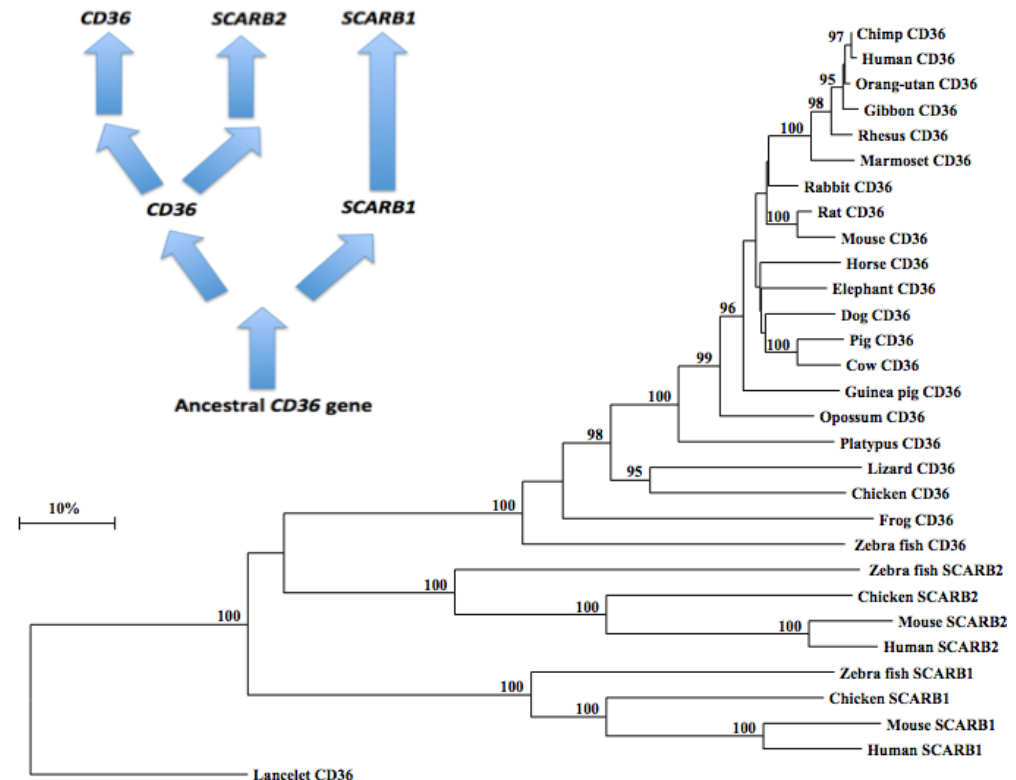
Figure 5. Phylogenetic Tree of Vertebrate CD36 Amino Acid Sequences with Human, Mouse, Chicken and Zebrafish SCARB1 and SCARB2 Sequences. The tree is labeled with the CD36 -like gene name and the name of the animal and is ‘rooted’ with the lancelet CD36 sequence. Note the 3 major clusters corresponding to the CD36 , SCARB1 and SCARB2 gene families. A genetic distance scale is shown. The number of times a clade (sequences common to a node or branch) occurred in the bootstrap replicates are shown. Only highly significant replicate values of 95 or more are shown with 100 bootstrap replicates performed in each case. A proposed sequence of CD36 gene duplication events is